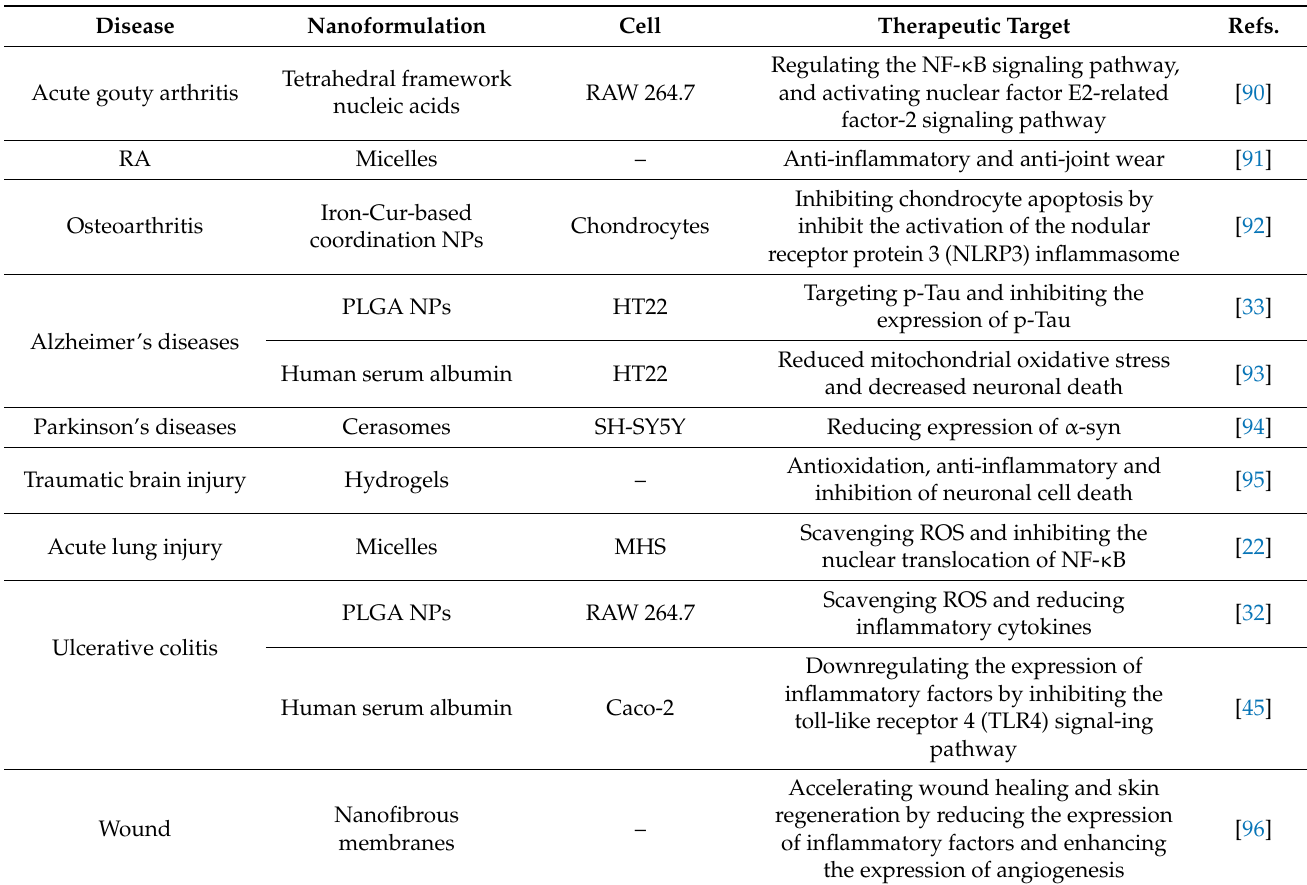
Table 2. Representative application of Cur nanoformulations in inflammatory